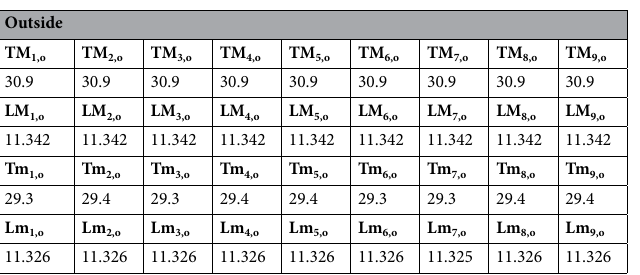
Table 1. Values of relative maxima and minima of temperature (T) and inductance (L) of the curves in Fig. 2a. All the peaks with the same temperature show the same inductance values. Results for the valleys are slightly